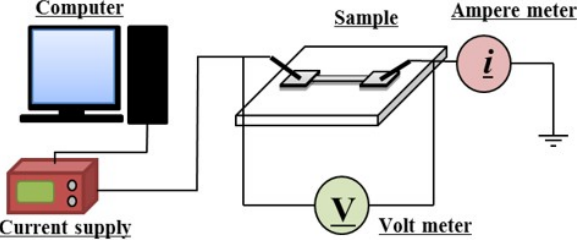
Figure 1. Schematic diagram of the electrical sintering setup for the SCIS technique.